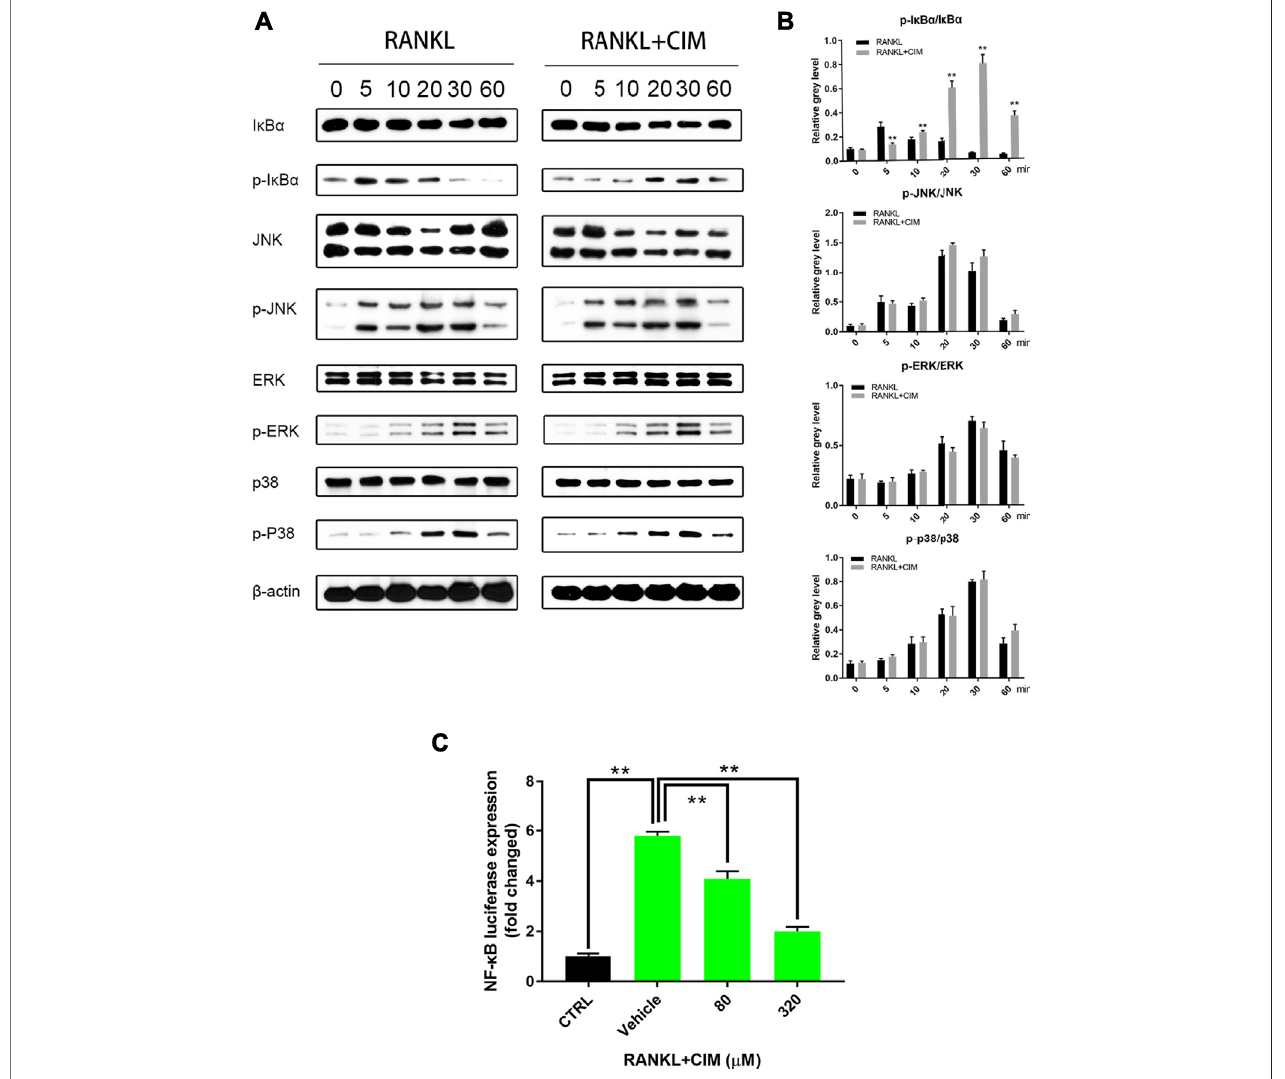
FIGURE 4 | CIM downregulates the NF- κ B signaling pathway but not the MAPK signaling in RANKL-pretreated osteoclast precursors. (A) Chronological Western blot band spectra corresponding to key factors and their phosphorylated forms in the NF- κ B and MAPK (JNK, ERK and p38) signaling pathways in BMMs pretreated with 320 μ M CIM and RANKL are presented; the levels were compared to those in the control group (only RANKL). (B) The levels of phosphorylated NF- κ B and MAPK proteins were normalized to their total levels and analyzed. (C) The luciferase activity of RAW264.7 cells transfected with the NF- κ B luciferase reporter gene was quanti fi ed. (**: p < 0.01 compared with the control